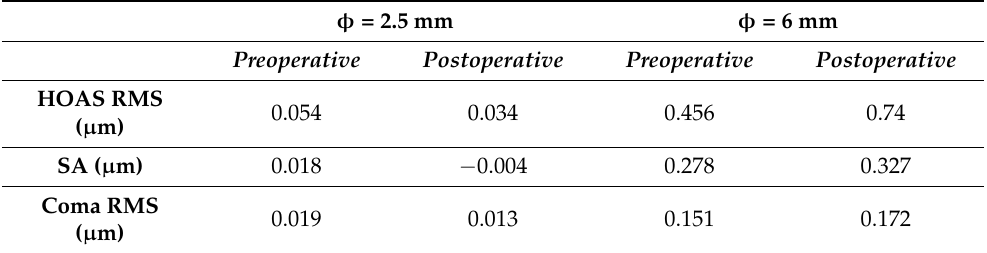
Table 4. Preoperative and postoperative RMS HOAS, SA and RMS coma values of Eye 1 for 2.5 mm and 6 mm pupil